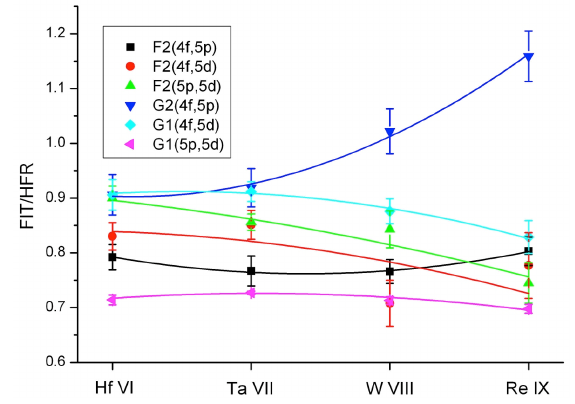
Figure 5. Scaling factors (ratios FIT/HFR) for main electrostatic parameters in the 4f 13 5p 5 nl and 4f 14 5p 4 nl